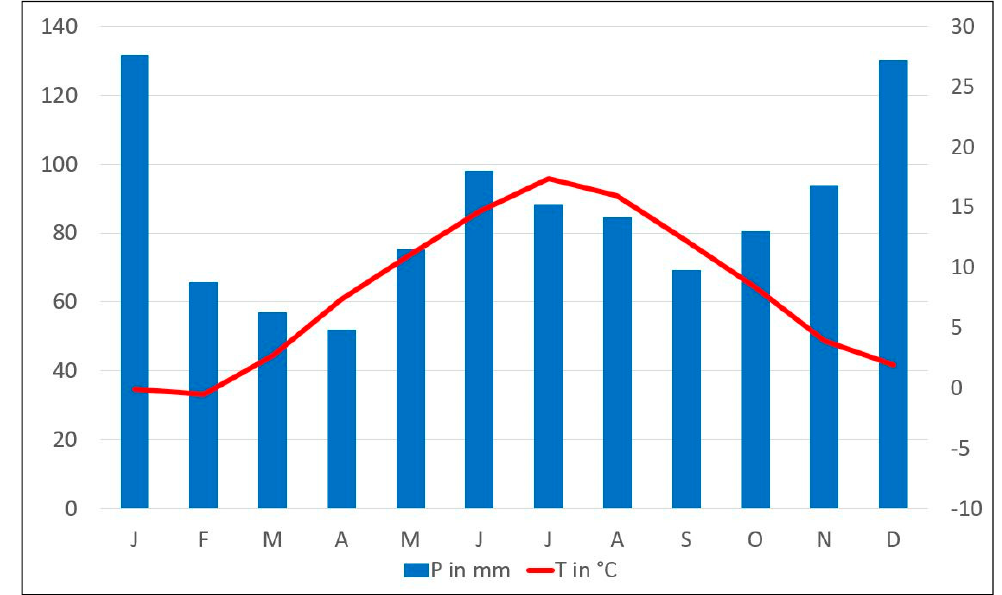
Figure 2. Climate graph for Hüttgeswasen.